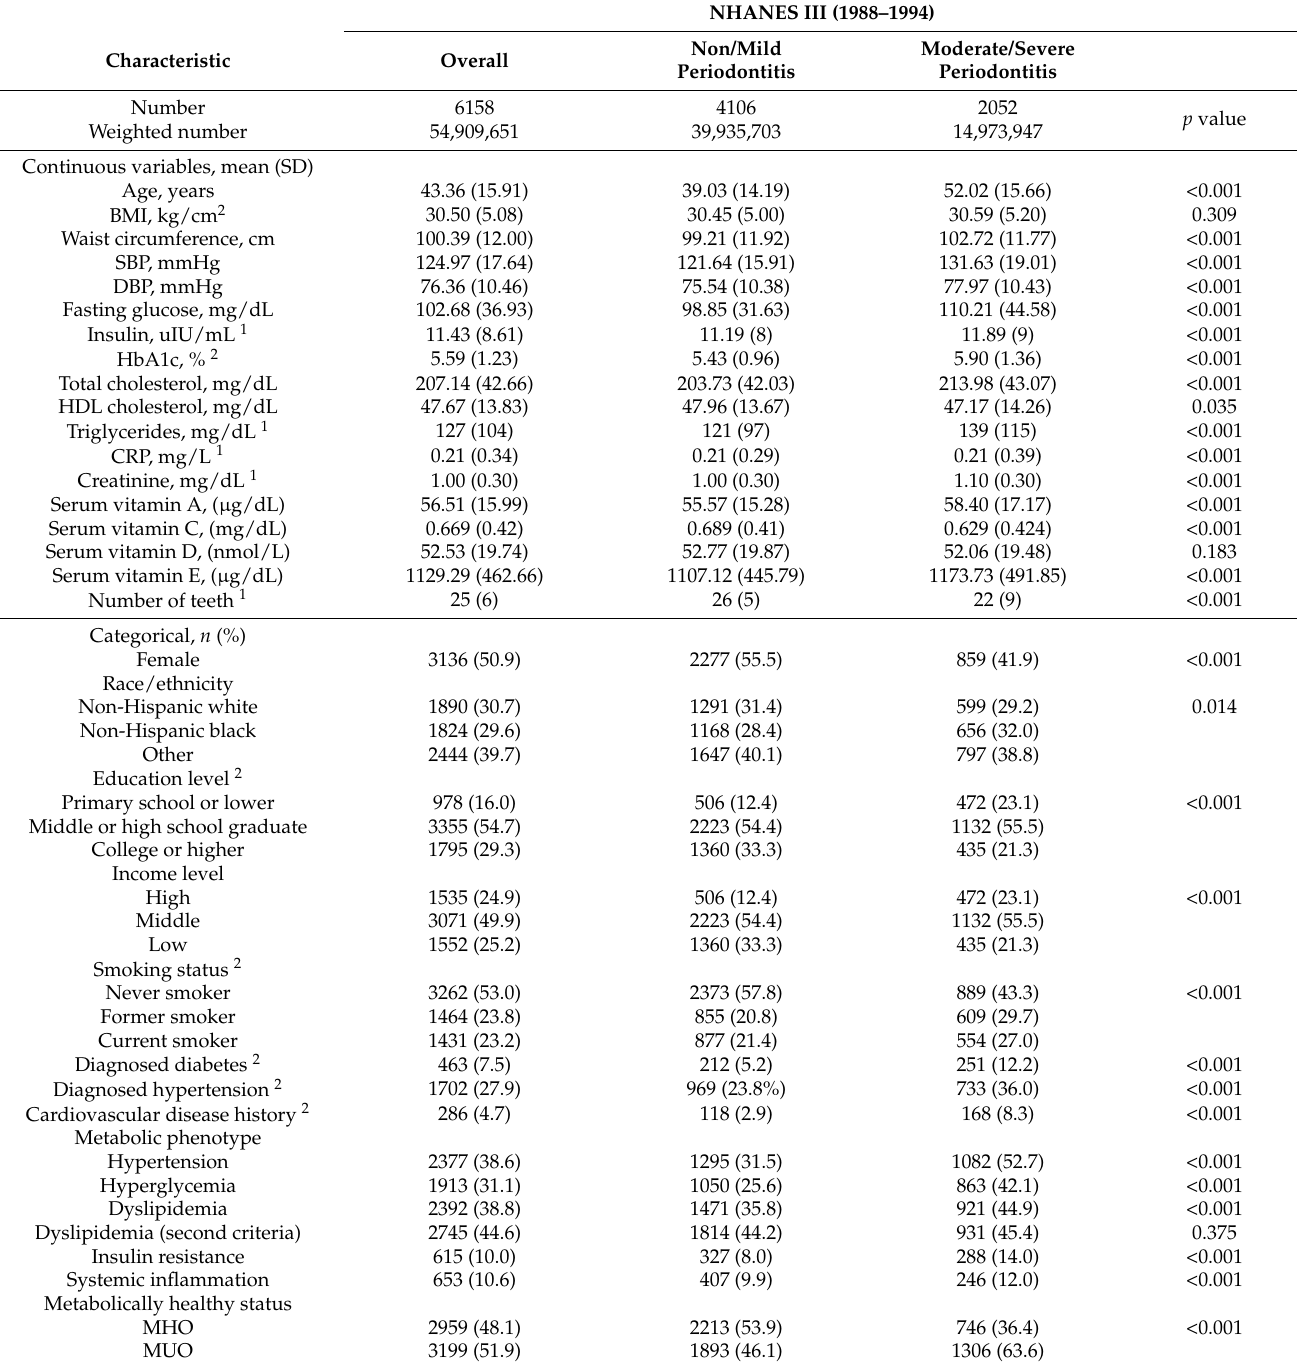
Table 1. Characteristics of study population in NHANES III by periodontal